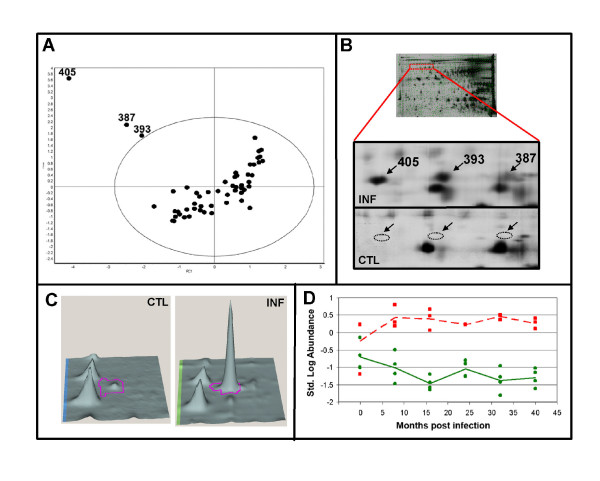
Differentially abundant spot features. Principle component analysis of 56 spot features that exhibited statistically significant (ANOVA p < 0.01) changes in abundance and were present on all 40 gels (A). The red rectangle on the gel image shows the region on the gels where the potential outliers were situated. Two magnified views of this region showing infected and control images (B). 3D images of spot feature 405 showing the 23.68 fold increase in abundance observed at 8 mpi (C). Graphical representation of the standardized log abundance data obtained for spot feature 405 (D).